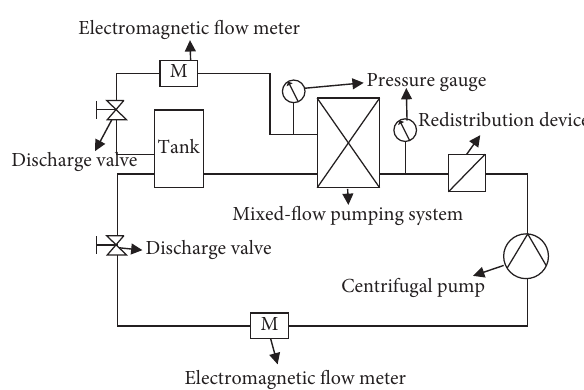
Figure 7: Waterjet propulsion device test system